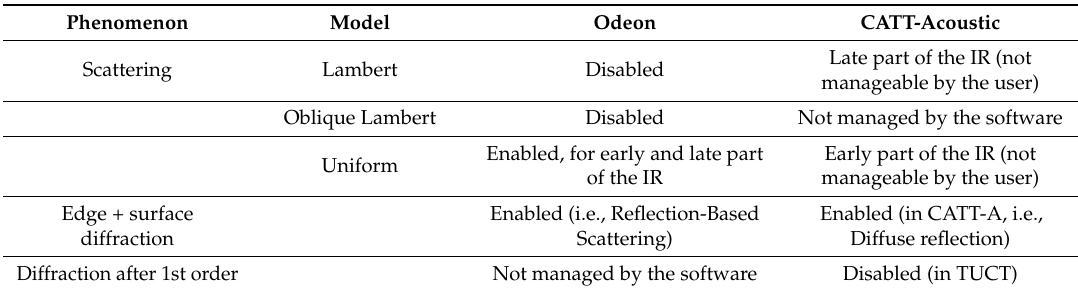
Table 2. Scattering and diffraction set-up in Odeon and